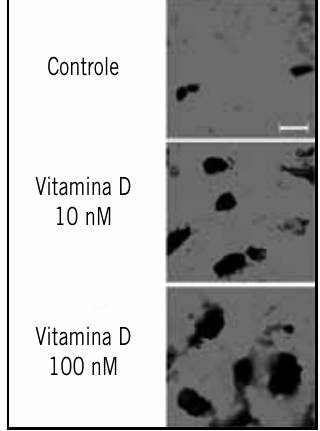
Figura 2 – Coloração de Alizarin Red em calvárias cultivadas na ausência de vitamina D (controle) e com diferentes dosagens de vitamina D por 72 horas As áreas escuras representam as lacunas de reabsorção óssea (microscopia confocal; barra = 50 µm).